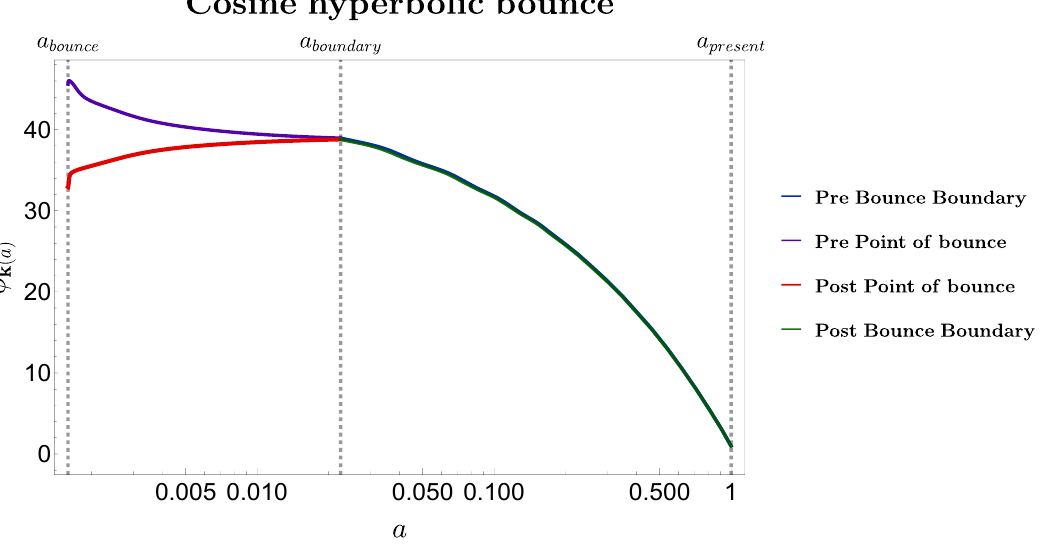
Figure 10: Squeezing angle plotted at different regions against scale